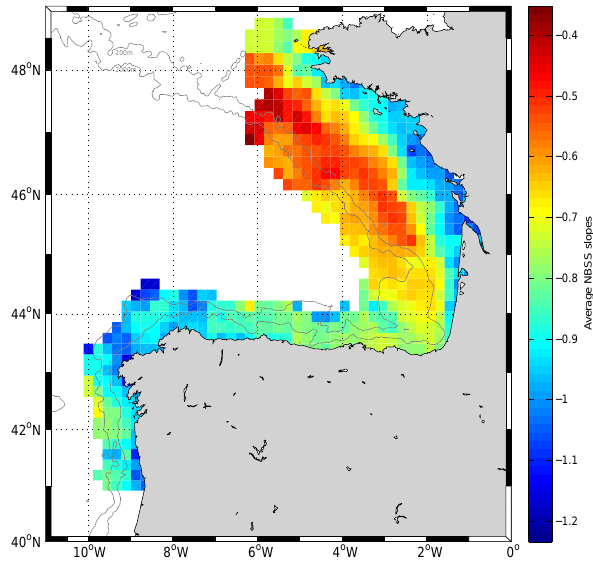
Figure 9. Spatial distribution of zooplankton productivity (in log 10 mgCm − 2 d − 1 ) estimated by the PLS (partial least square) in- tegrated from the surface to a maximum of 100m